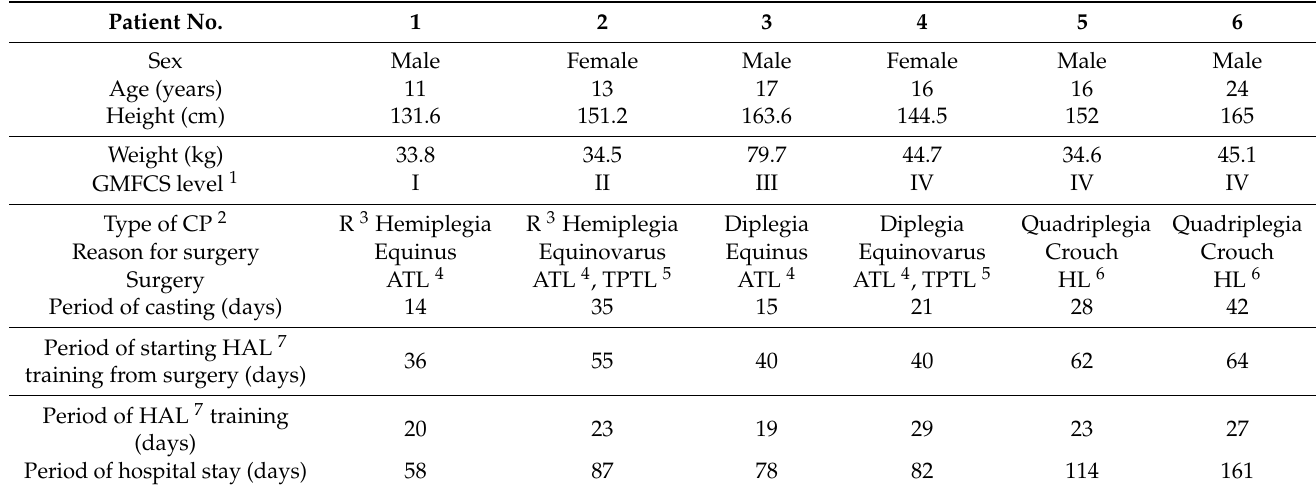
Table 1. Patient characteristics and surgical details.